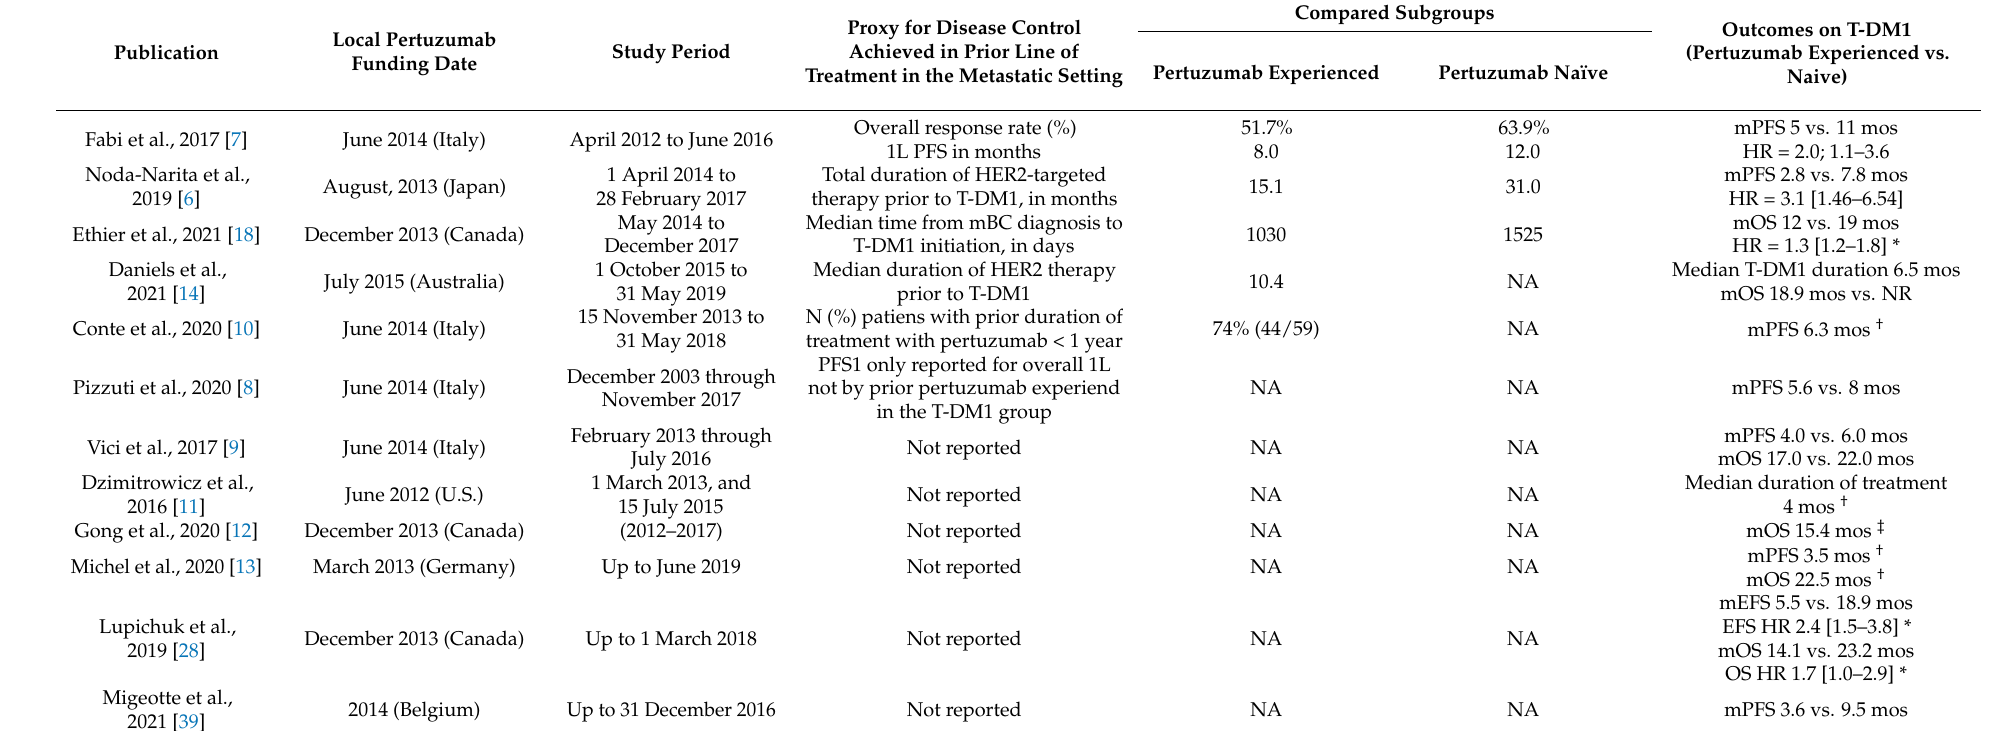
Table A1. Summary of studies reporting effectiveness of T-DM1